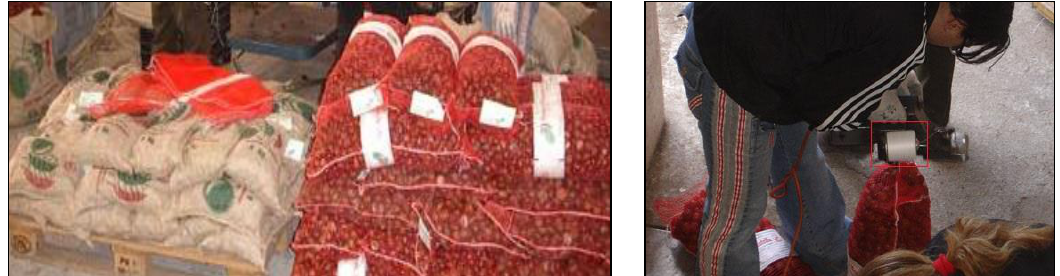
Figure 5. Examples of tagged packages and